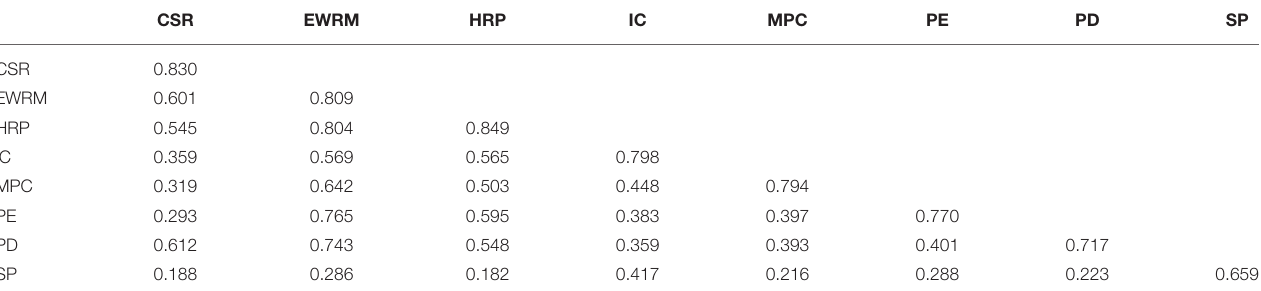
TABLE 3 | Discriminant